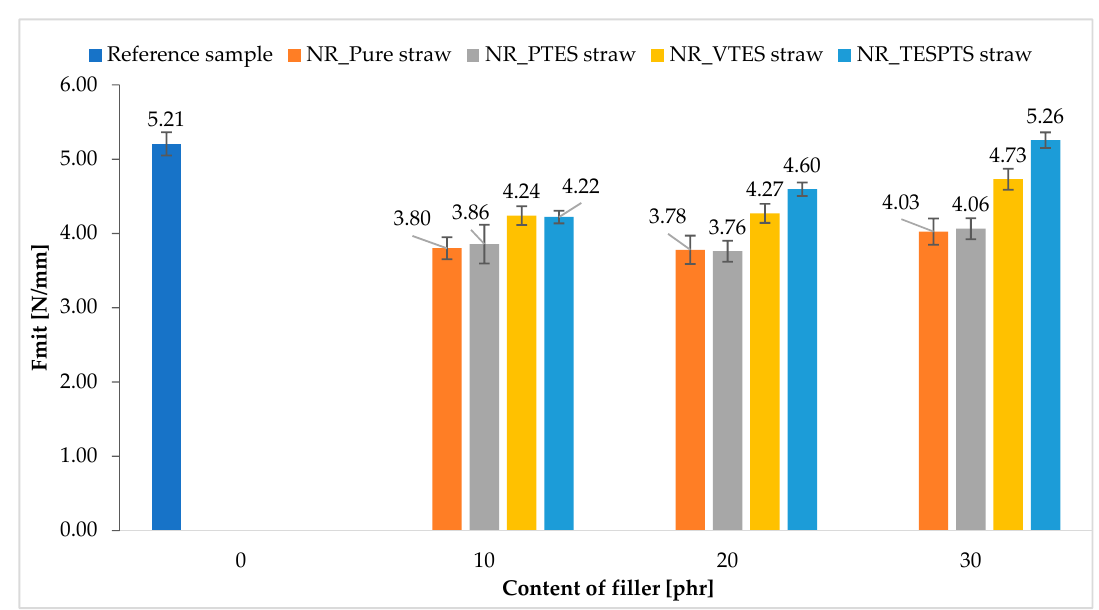
Figure 9. Tear resistance of natural rubber composites containing modified and unmodified straw.